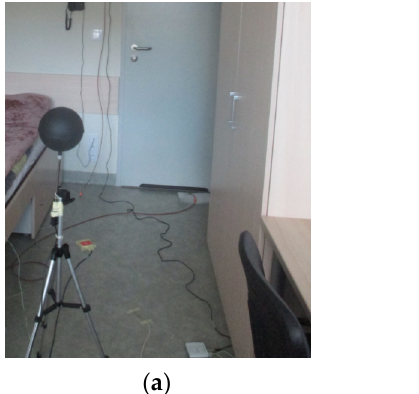
Table 1. The main metrological parameters of the measuring sensors used.